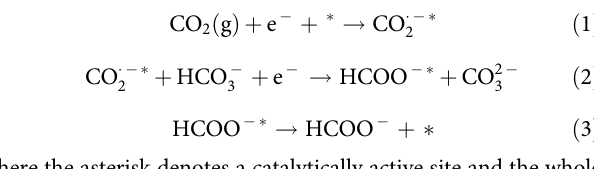
Fig. 4b,c. The results revealed that the V o -rich Co 3 O 4 single- unit-cell layer has a surface coverage of CO (cid:3)(cid:2)(cid:4) V o -poor Co 3 O 4 single-unit-cell layer has a surface coverage of E 0.27. CO (cid:3)(cid:2)(cid:4) 2